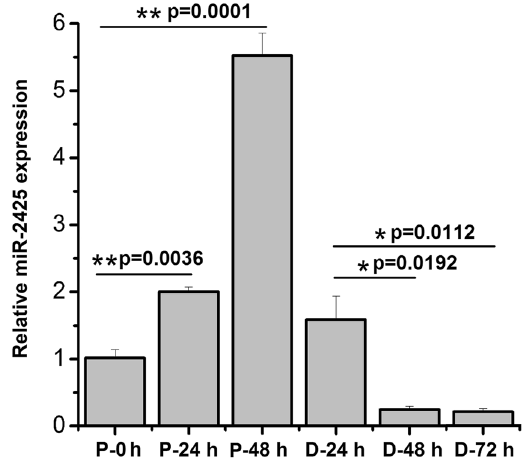
Figure 1. MiR-2425-5p expression during MDSCs proliferation and differentiation. P and D designate proliferating and differentiating cell cultures, respectively. Differentiation was induced with 2% horse serum. Results are shown as the mean ± SEM of three independent experiments. * P < 0.05, ** P < 0.01, NS: no significant